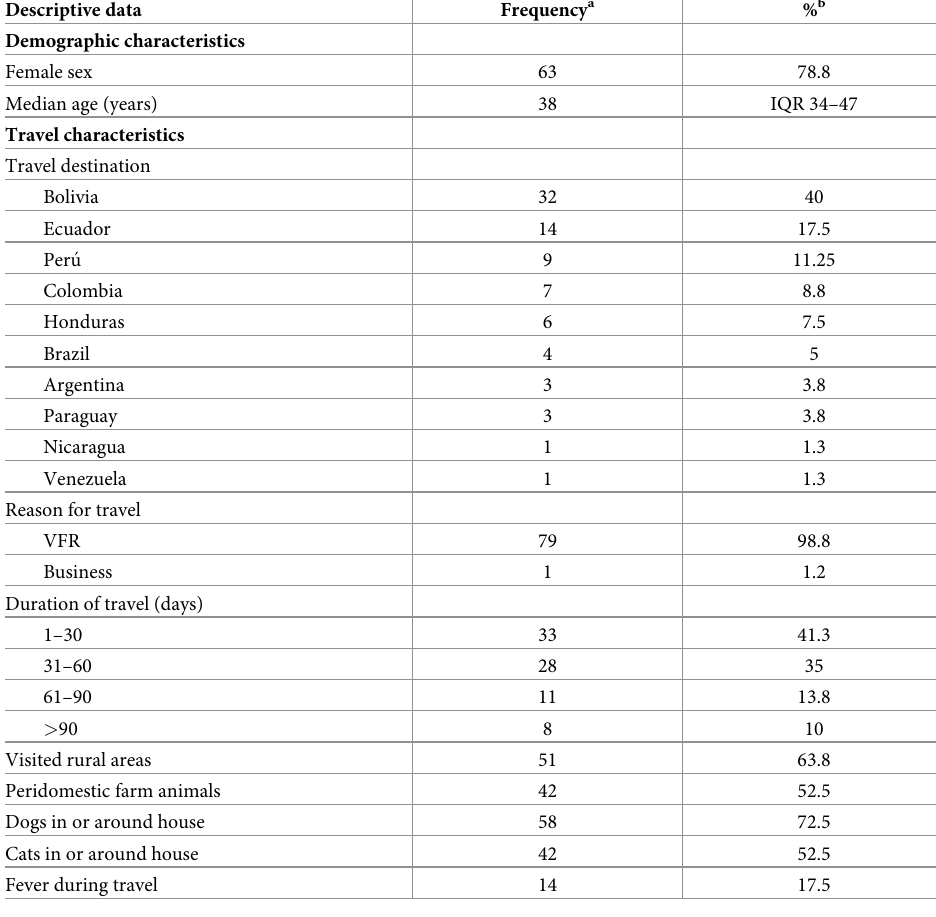
Table 1. Demographic and travel characteristics of study population (n = 80). VSF: visiting friends and relatives.